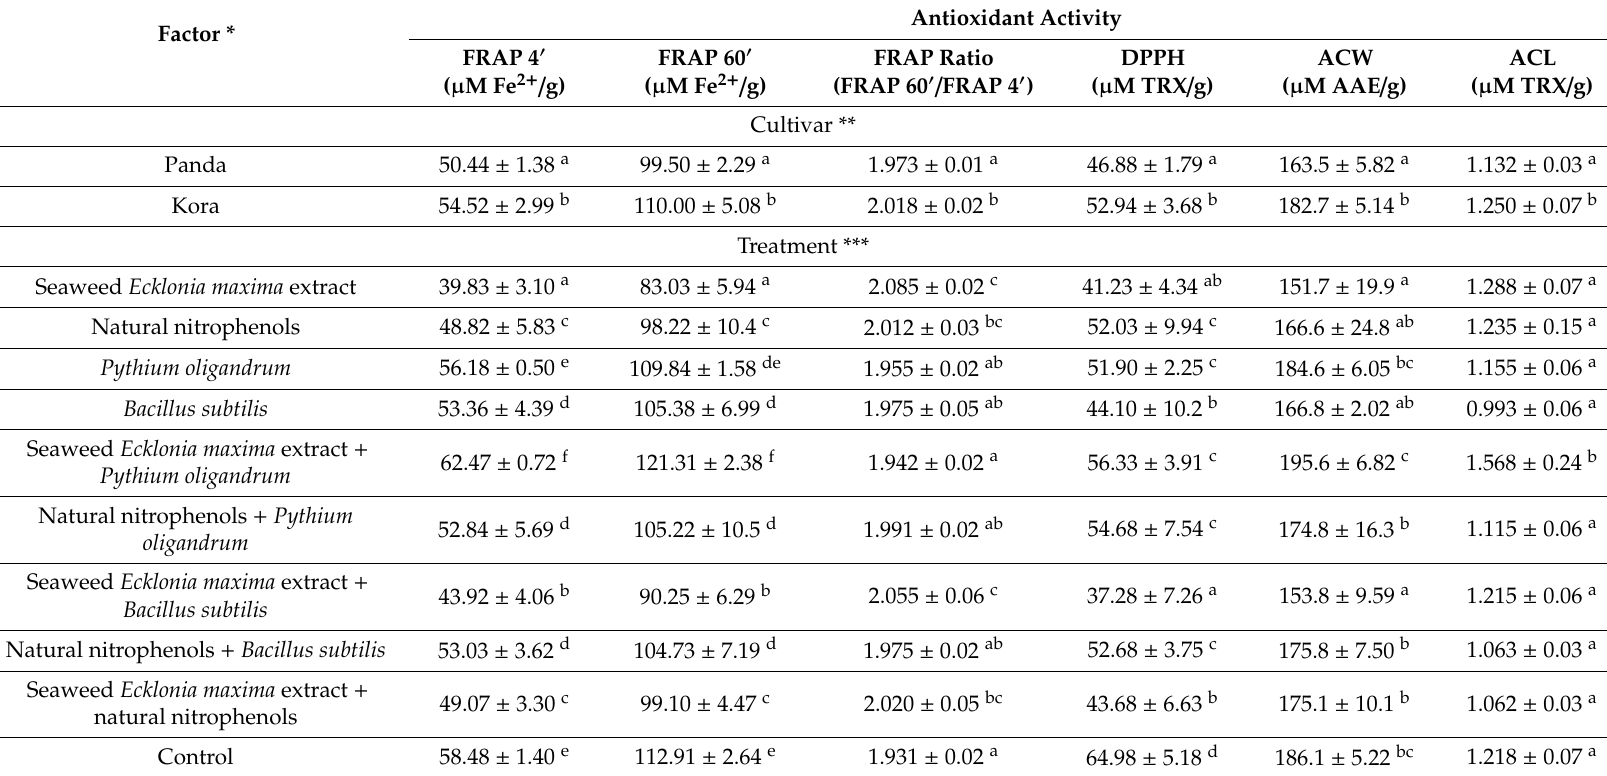
Table 1. E ff ect of cultivar and treatment on antioxidant activity of buckwheat